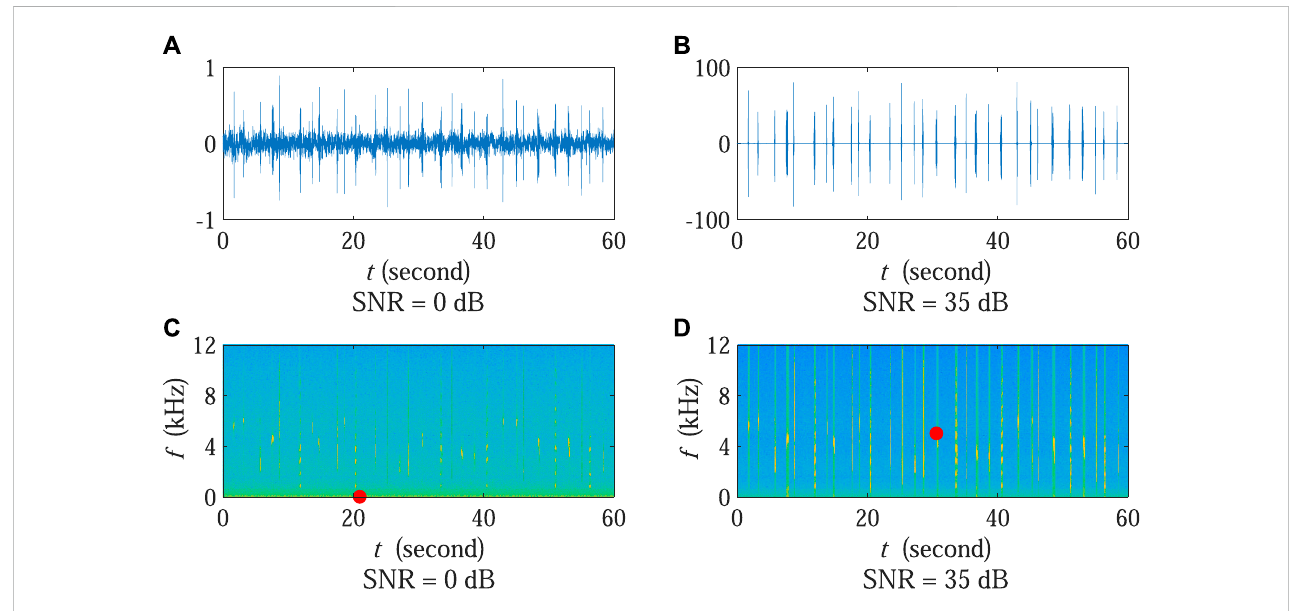
FIGURE 5 Waveforms and spectrograms under the two cases in Experiment 2 when calculating ADI and AEI. (A,B) present the signal waveforms under 0 dB and 35 dB SNR conditions, respectively. The corresponding spectrograms are shown in (C,D) . Each red dot marks the position of the time-frequency bin with the strongest power. Note that the amplitude scale of (A) is different from (B) .